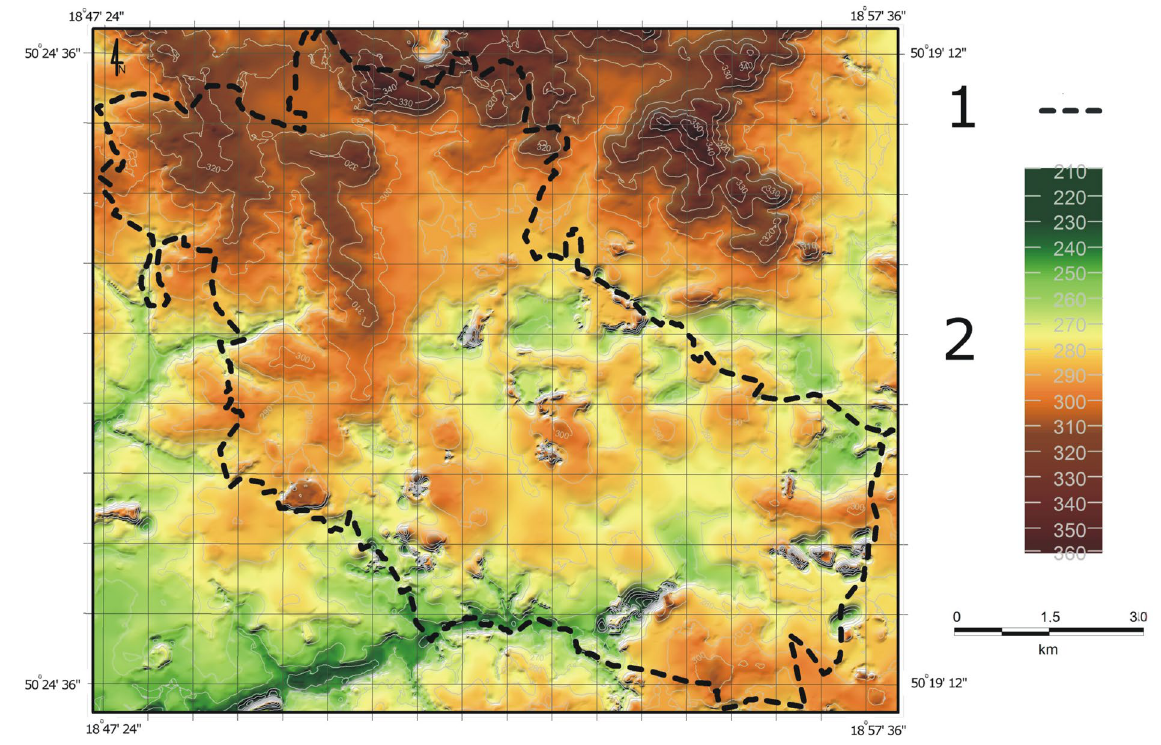
Figure 3. Land relief within the city of Bytom at the end of the twentieth century (within present-day city limits): 1—city boundary; 2—absolute elevation [m a.s.l.].